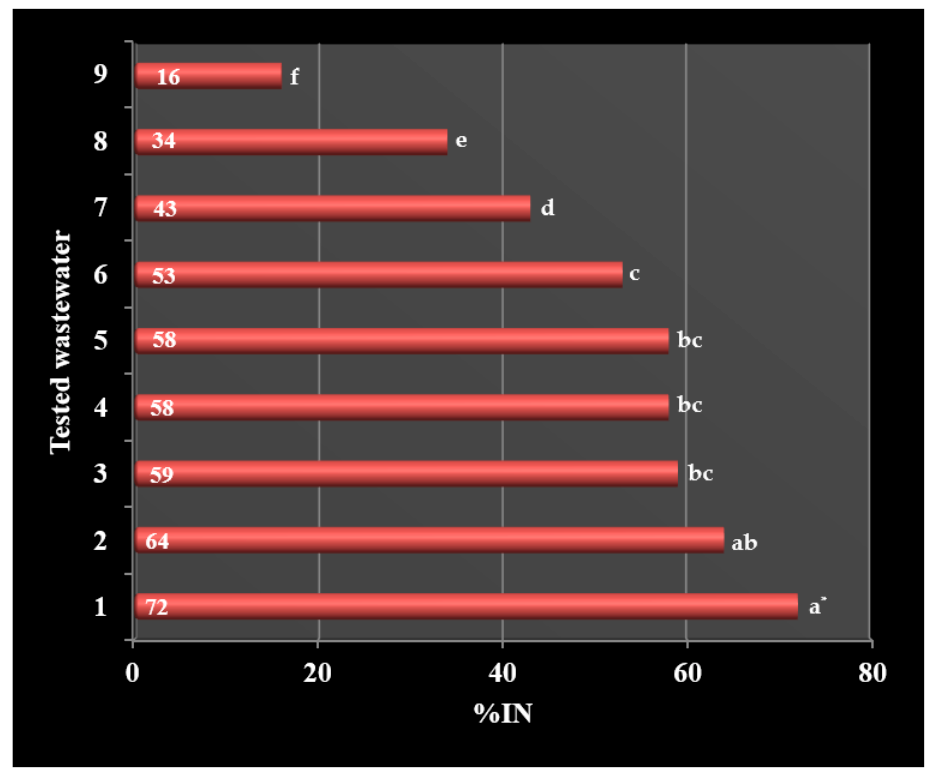
Figure 3. Percentage inhibition of nitrification. 1 styrene butadiene rubbers; 2 solvents: butyl acetate, ethyl acetate; 3 styrene; 4 acrylonitrile rubbers; 5 terpenes; 6 emulsifiers; 7 polyvinyl acetate; 8 polyvinyl chloride; 9 methacrylate. * Averages marked with the same letters are not significantly different by Tukey’s test ( α = 0.05).